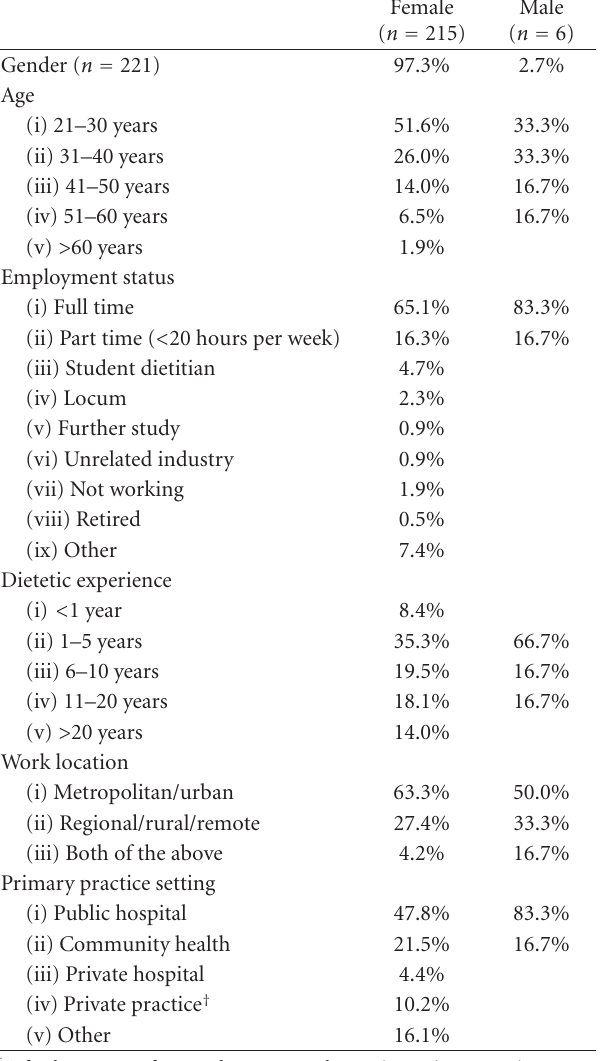
Table 2: Characteristics of 221 respondents to a web-based survey of current attitudes and practices of members of the DAA, in regards to diagnosis and current dietary management of malnutrition.